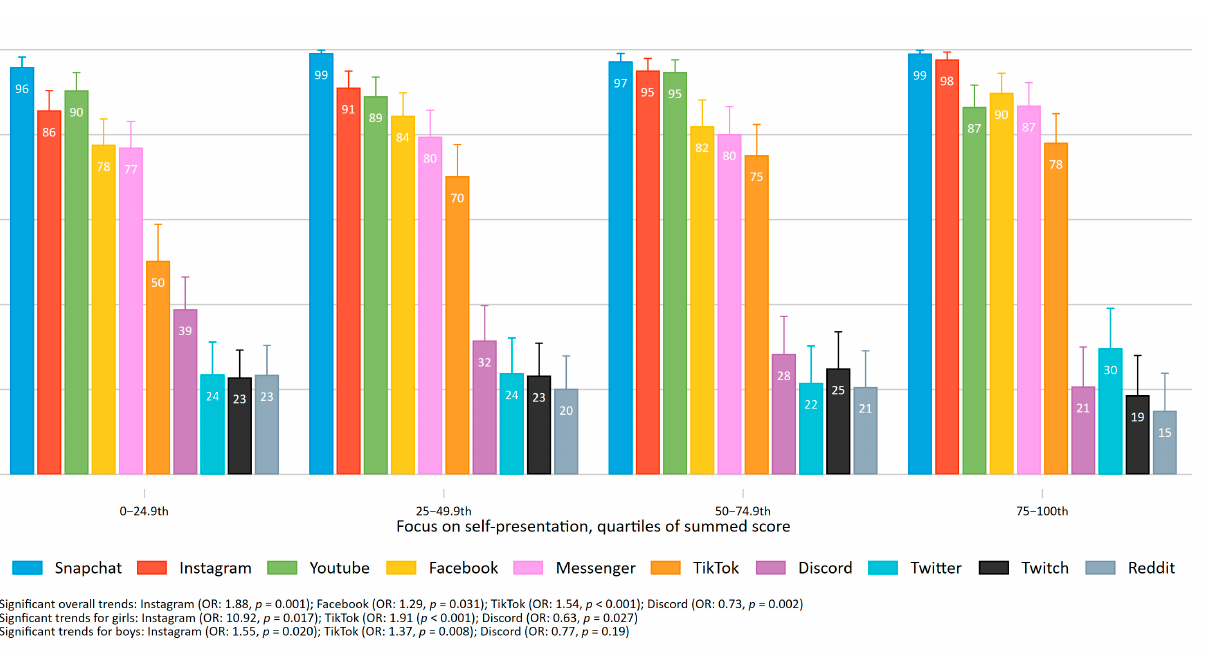
Figure 3. Gender-adjusted proportions of social media platforms used by the participants across quartiles of focus on self-presentation.